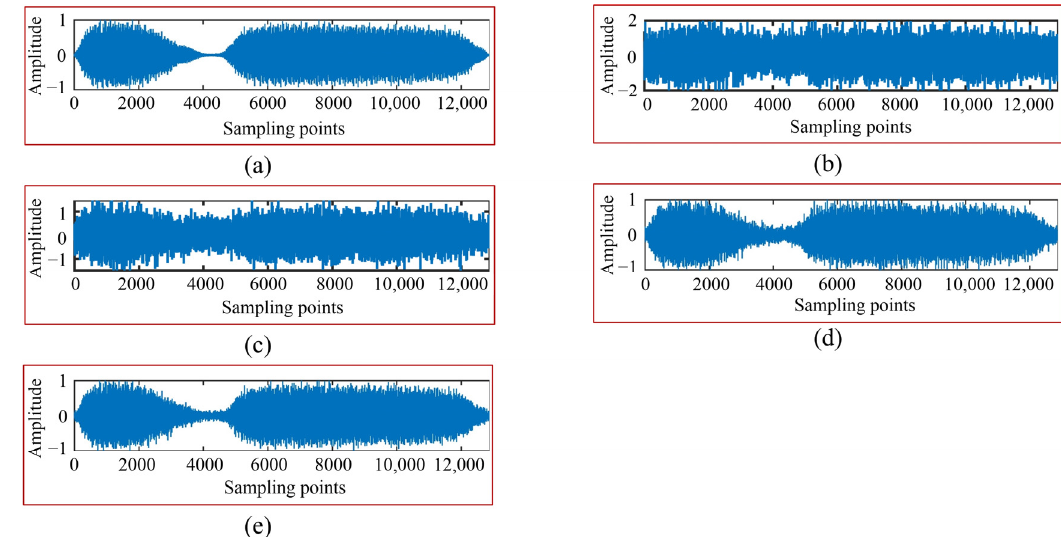
Figure 5. ( a ) Original sound signal; ( b ) SNR in = 0 dB noisy sound signal; ( c ) SNR in = 10 dB noisy sound signal; ( d ) SNR in = 20 dB noisy sound signal; ( e ) SNR in = 30 dB noisy sound signal.